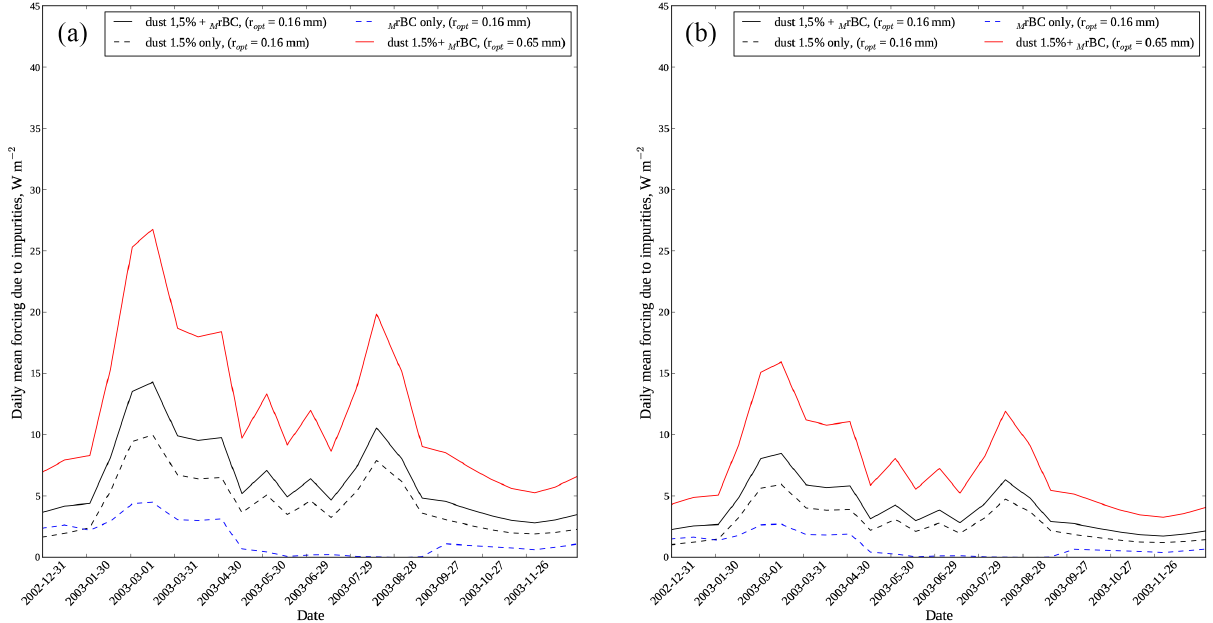
Figure 6. Daily mean forcing due to impurities under (a) clear sky (b) cloudy sky conditions in 2003 and for different combinations of impurities (dust with 1.5% hematite content) and snow grain